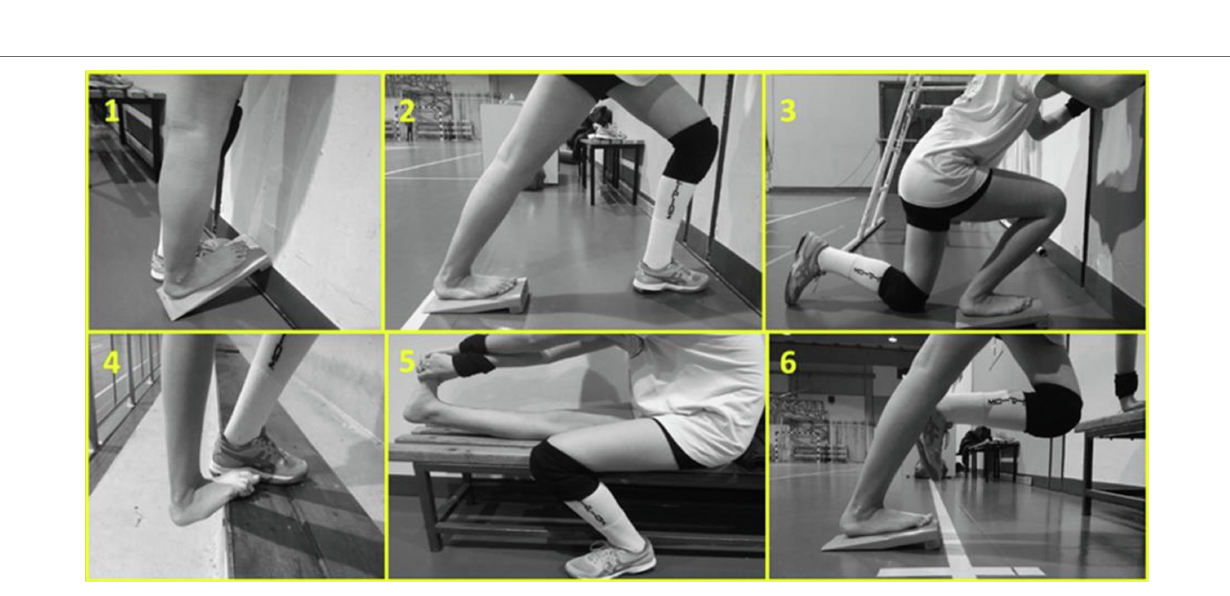
FIGURE 5 | Static stretching exercises targeting mainly triceps surae (1, 2, 4, 6) , soleus (3) and hamstrings and triceps surae (5, 6) .